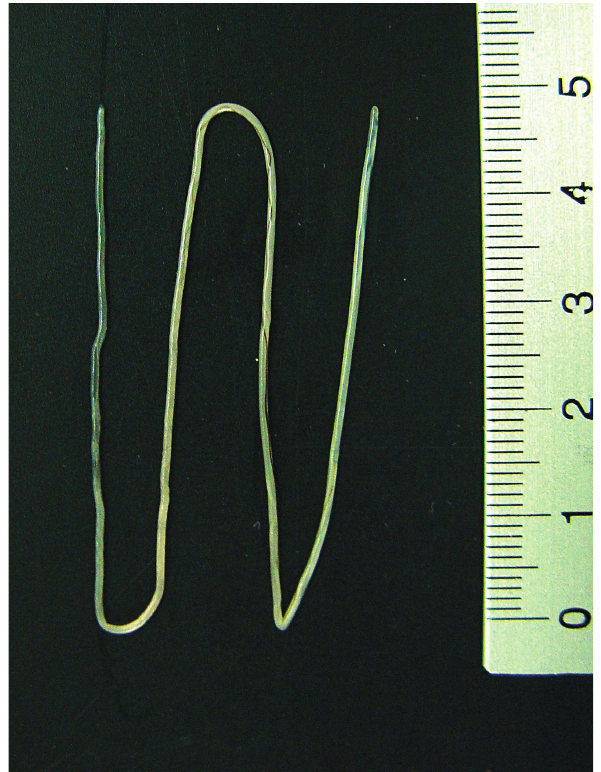
Fig. 2. – Dead adult female of Serratospiculum seurati , 0.8 × 220 mm in size, vomited by a reported falcon during the melarsomine the-